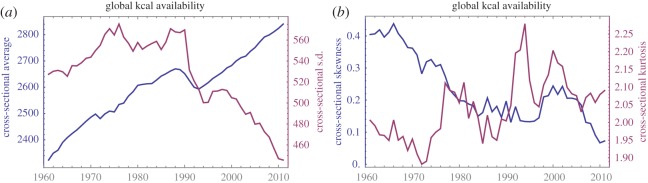
Global changes in kcal availability for 1961–2011. (a) Evolution of the global average (blue) and standard deviation (red) in country-level kcal availability, indicating both growth and convergence during this period (with an exception around 1990). (b) Evolution of the sample skewness (blue) and sample kurtosis (red) for the same dataset, indicating non-normality of the global distribution of kcal availability.